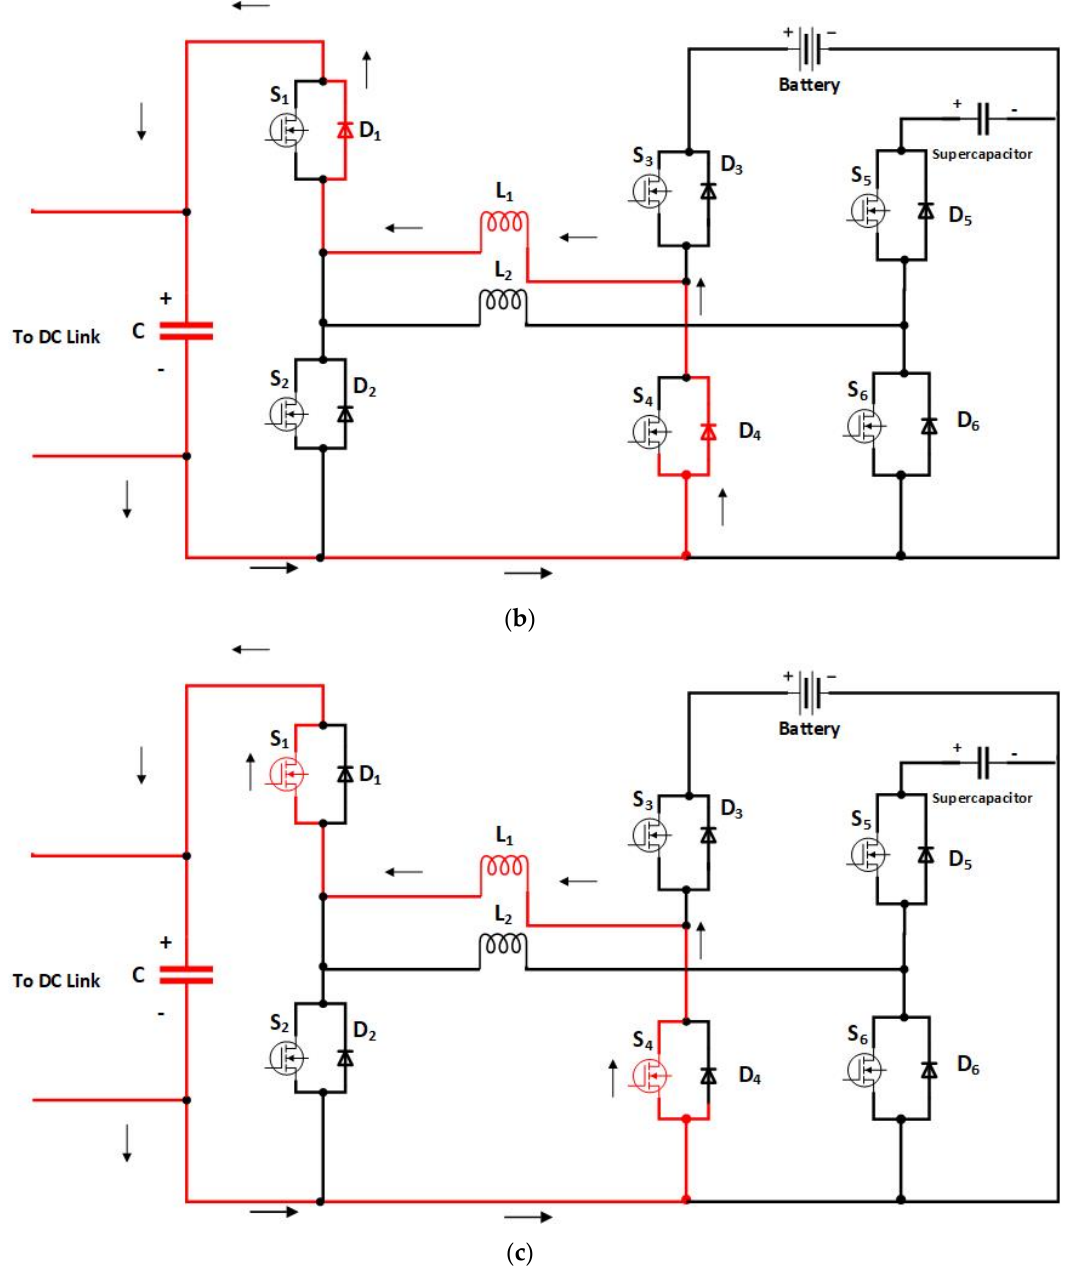
Figure 6. ( a ). Mode 1(a): T1 charging L1 from battery. ( b ) Discharging from L 1 in DC link through the diodes. ( c ) Discharging from L 1 in DC link through the switches. the diodes. ( c ) Discharging from L 1 in DC link through the